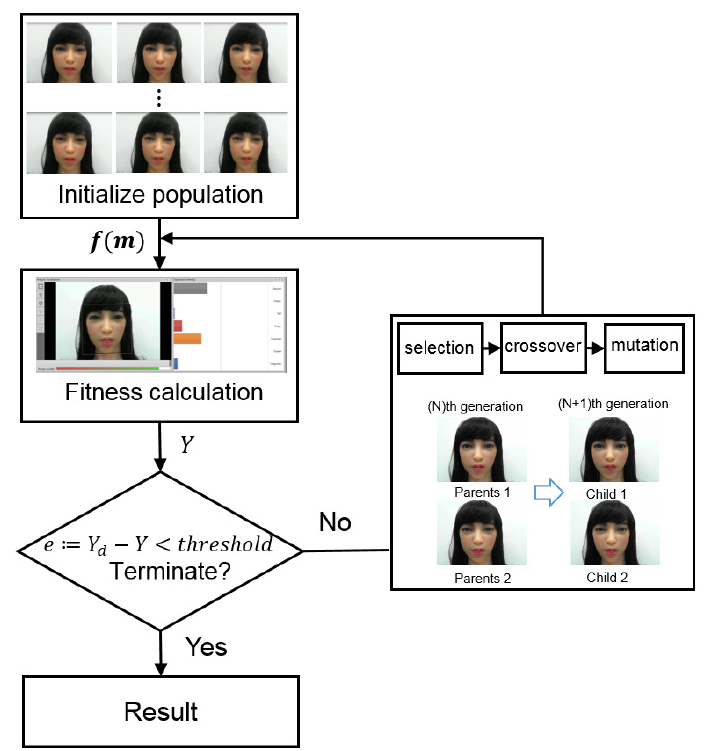
Figure 7. Genetic algorithm (GA) for generating facial expressions of the EveR